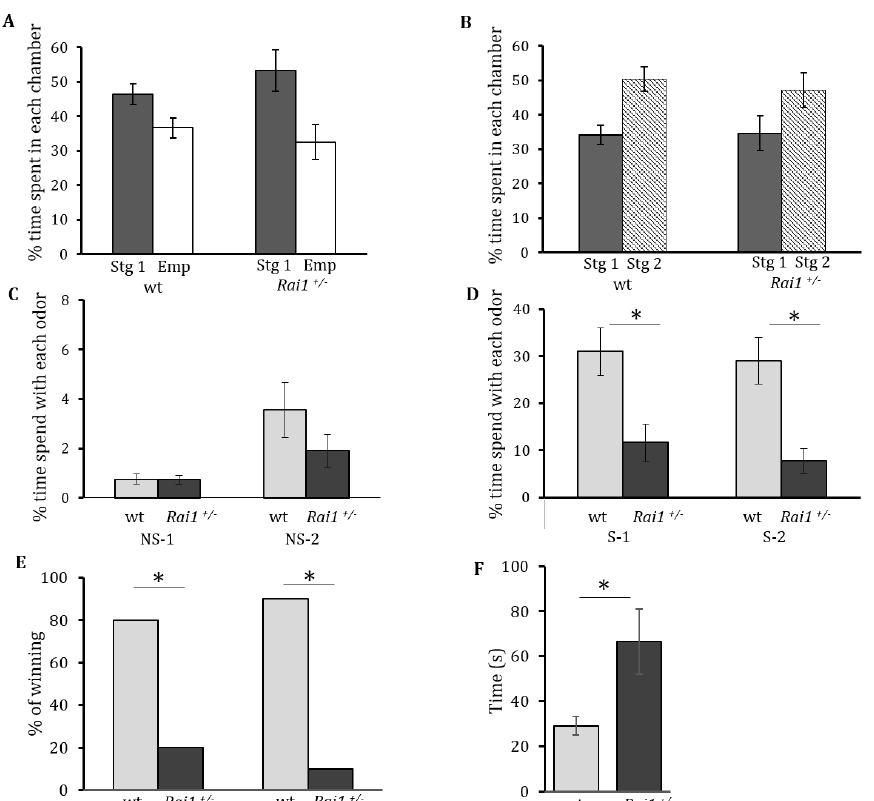
Figure 1. Evaluation of social behaviors in Rai1 +/- mice. (A) Sociability in Rai1 +/− mice is shown. Percentages of time spent in the chamber side with stranger 1 (Stg1, black column) or with the empty container (Emp, white column) during the sociability test are shown for the wild type and Rai1 +/− mice. ( B ) Social novelty preference was evaluated. Percentages of time spent in the chamber side with stranger 1 (Stg1, black column) or with stranger 2 (Stg 2, striped column) during the preference for social novelty test are depicted. ( C ) The amount of time spent smelling non-social (NS) odors for both genotypes is shown. NS1 = Almond, NS2 = banana. ( D ) The amount of time spent smelling social (S) odors for both genotypes is shown. ( E ) Tube test. The results for the first and second round are depicted as the percentage of winning for each genotype. Wild type mice (grey column) and Rai1 +/− mice (black column) are represented. ( F ) Total time spent self-grooming for each genotype is shown. Wild type animals are represented in the grey column and Rai1 +/− mice in the black column. Asterisk denotes significant difference (* p < 0.05). The mean ± SEM values are depicted.